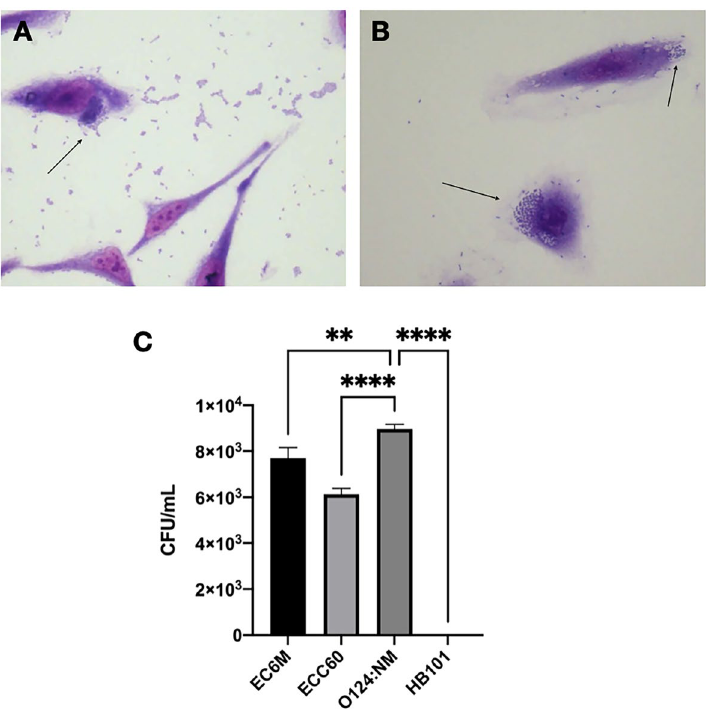
Figure 4. Invading phenotype exhibited in vitro by E. coli strains C6O O36:H5 ( A ) and 6 M O86:H18 ( B ). Arrows point to the invasion sites. Magnification 400x. The number of invading bacteria was determined by the invasion assay ( C ) and compared to 0124:NM (positive control) and HB101 (negative control) strains; ** < 0.01 **** <